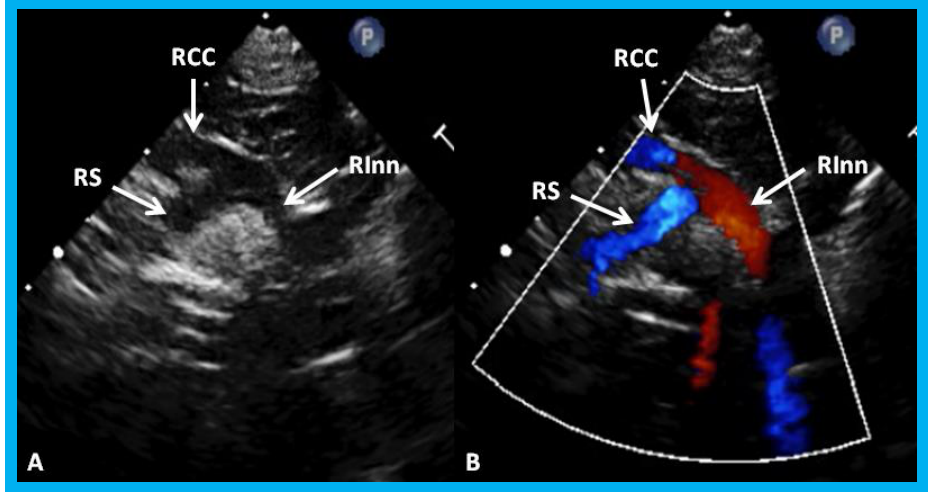
Figure 28. High parasternal views of the right innominate (RInn) artery demonstrating its division into right common carotid (RCC) artery and right subclavian (RS) artery by 2D ( A ) and color flow imaging ( B ): These data suggest left aortic arch.